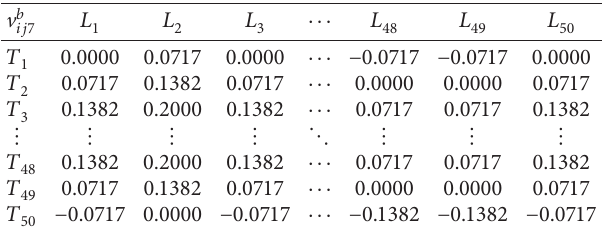
Table 30: Normative profit and loss matrix D tenants’ housing online ratings.